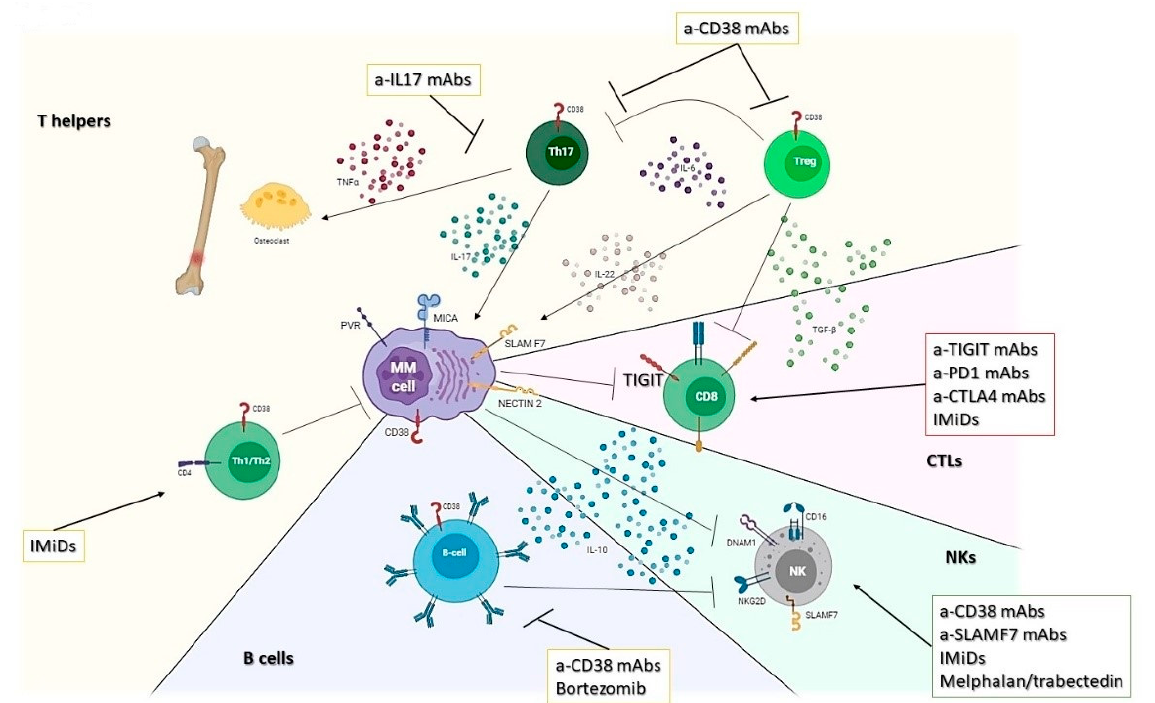
Figure 2. Role of B, T, and NK lymphocytes in MM niche. Cartoon representing the interplay existing between bone- marrow-infiltrating lymphocytes and MM cells. Therapeutic opportunities are reported according to the pathways/cells they interact with.